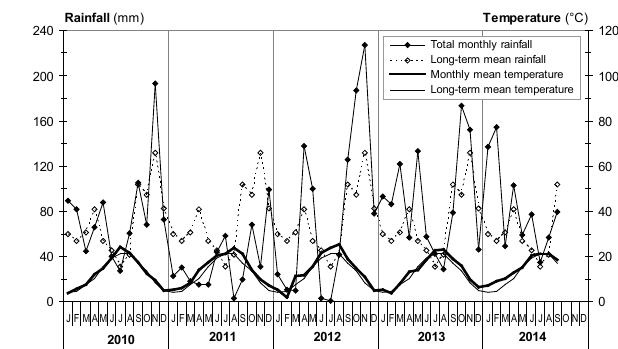
Figure 2. Rainfall and temperature during the experimental period with their respective long-term average trends (1990–2010).